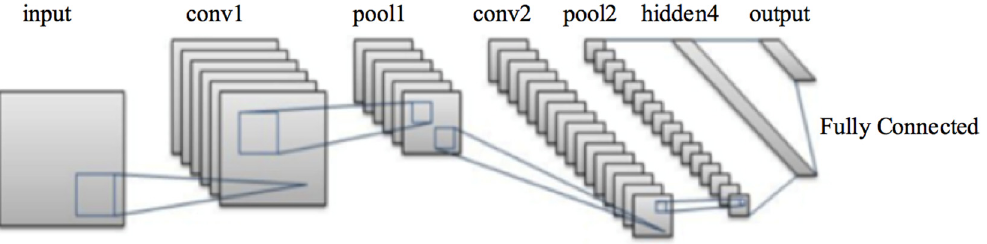
Figure 7. Architecture of the proposed convolutional neural network (CNN). Table 3. Summary of the proposed convolutional neural network (CNN) architecture.